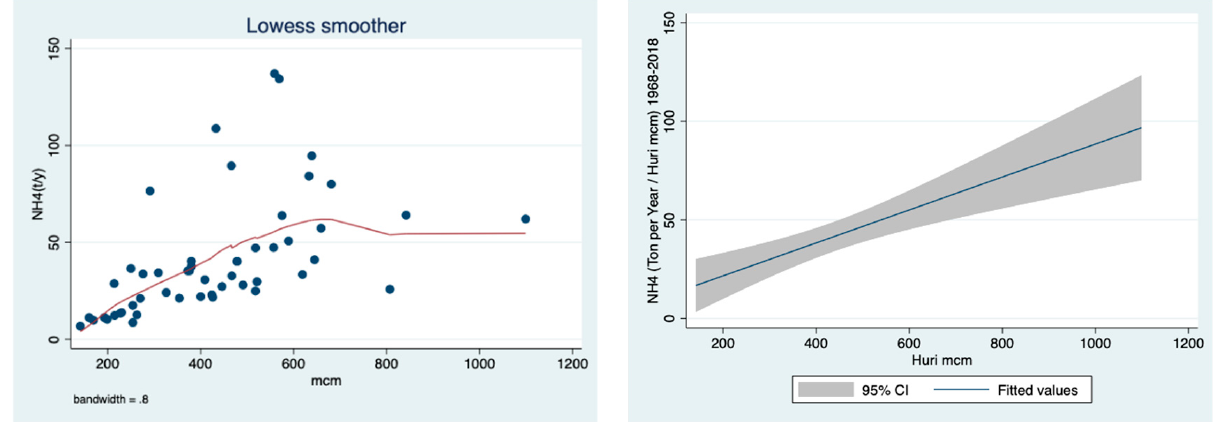
Figure 5. Linear prediction (95% CI) ( left ) and LOWESS smoother (0.8 bandwidth) trend of changes ( right ) between annual loads (ton) of ammonium in River Jordan and annual discharge (mcm;10 6 m 3 per year) of River Jordan (Huri Station) during 1968–2018.